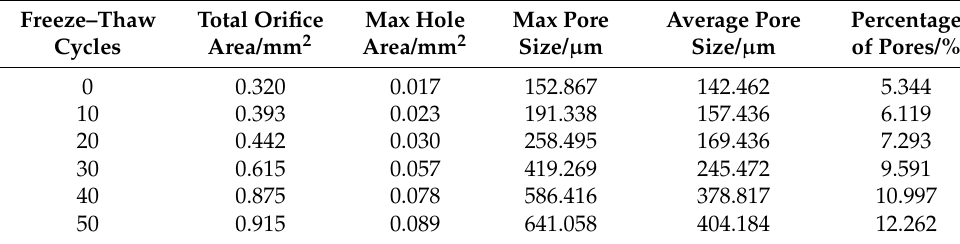
Table 3. Pore parameters of tailings under different freeze–thaw